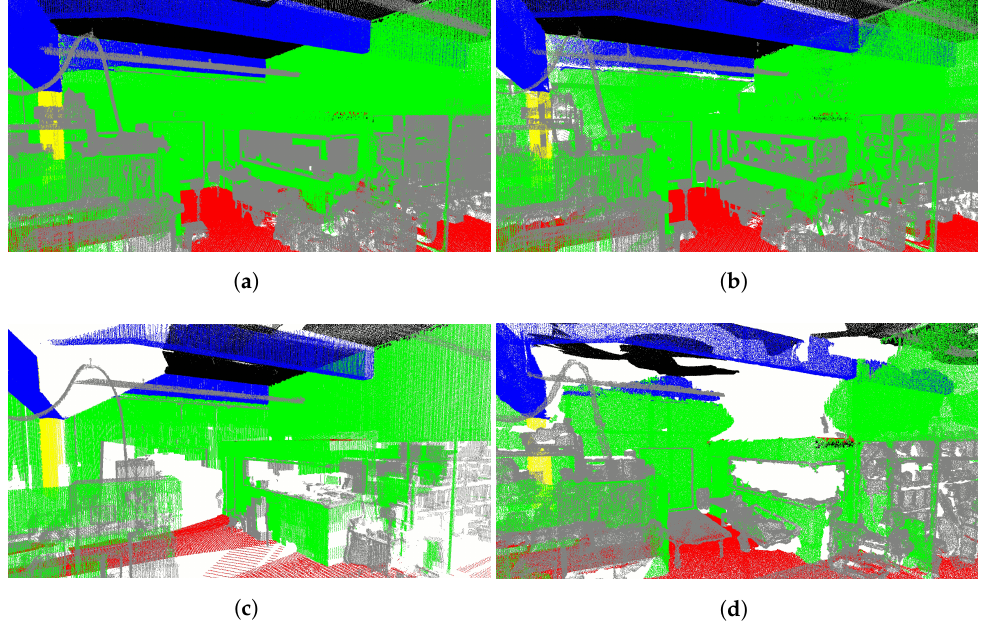
Figure 10. Coverage shortcomings: Due to the limited range of the Hololens 2, parts of higher walls cannot be captured properly. ( a ) VLX, ( b ) M6, ( c ) P30, and ( d ) Hololens